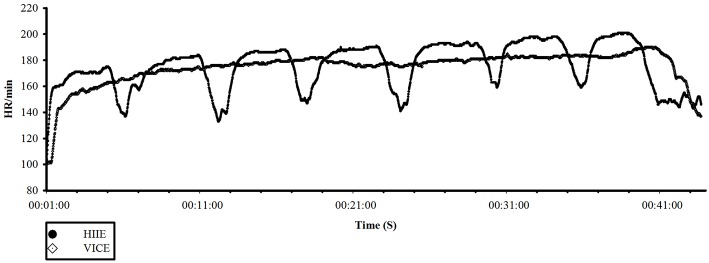
Heart rate curves for a representative subject performing high-intensity interval exercise or vigorous-intensity continuous exercise (VICE).